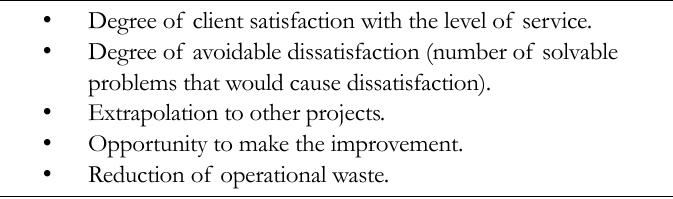
Table 3. Key decision